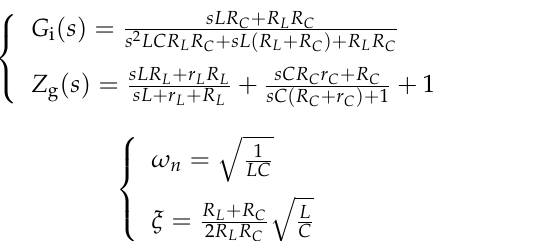
v g Figure 9. 3CH4 current source inverter grid-connected control block: ( a ) PI control with grid voltage feed-forward; ( b ) PI control with AD & PD grid voltage feed-forward.